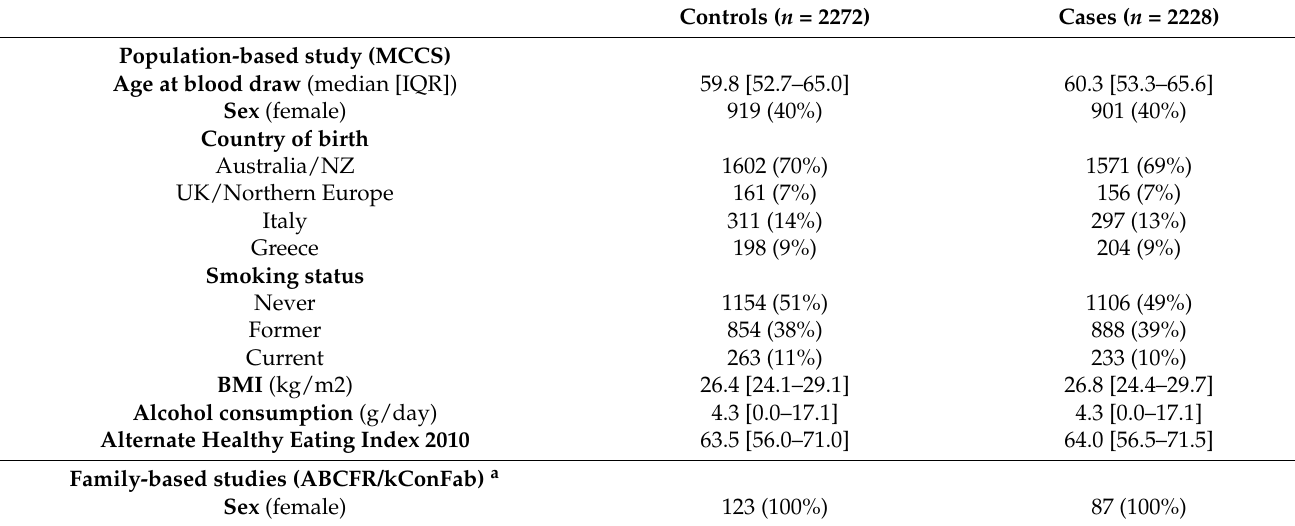
Table 1. Characteristics of the population-based and breast cancer family-based